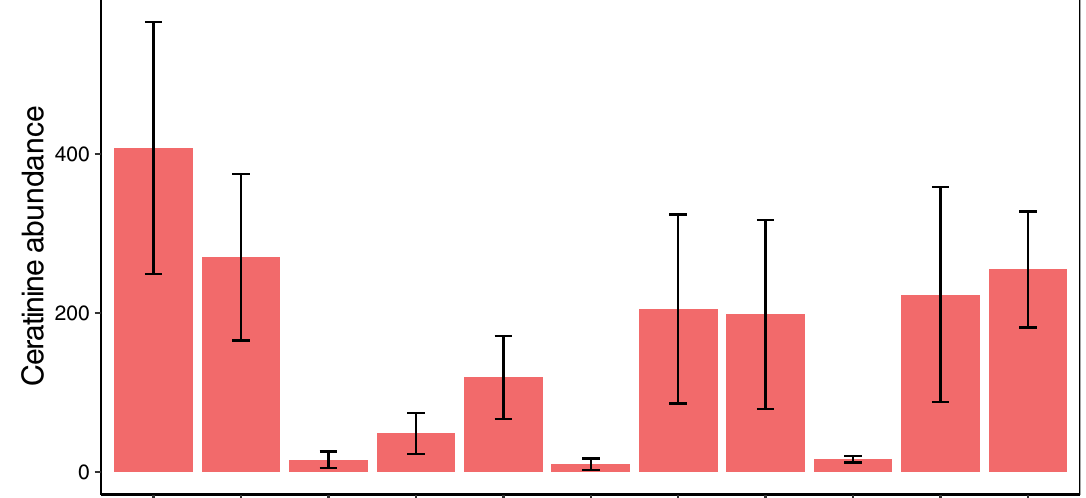
Figure 1. Mean (± SE) abundance of Ceratinine bee species, C. rectangulifera and C. trimaculata collected from pan traps, vane traps, and aerial netting at vegetation across three replicate elevational gradients, comparing wet season (June/July) and dry season